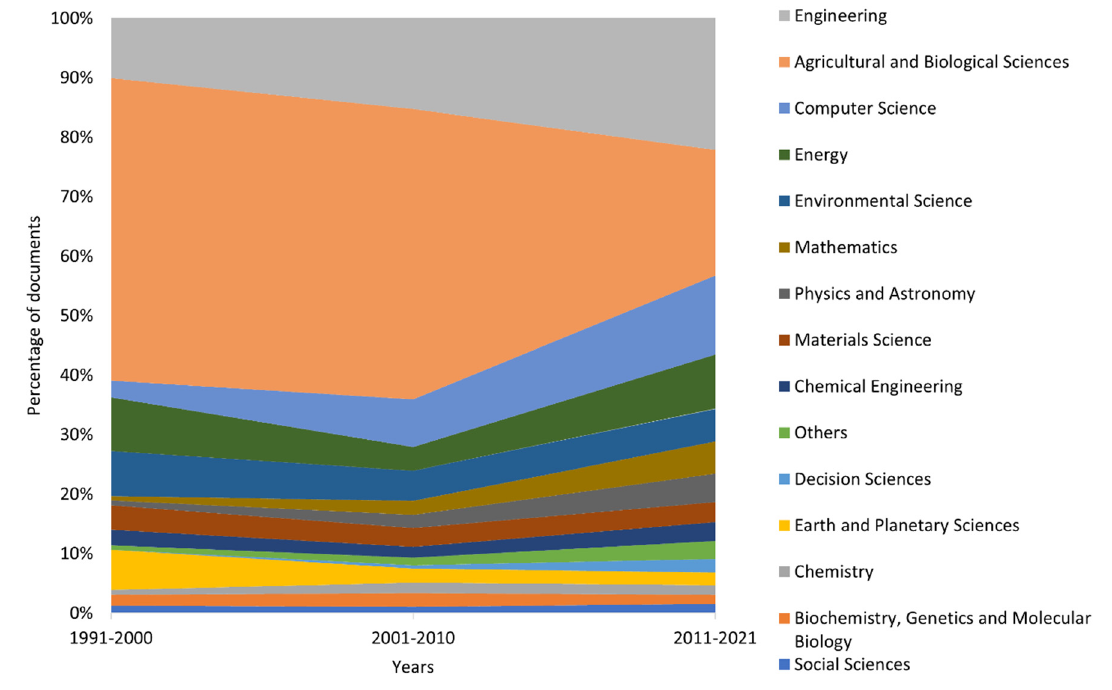
Figure 4. Trend of the distribution of the publications by Scopus category in 1991–2021.